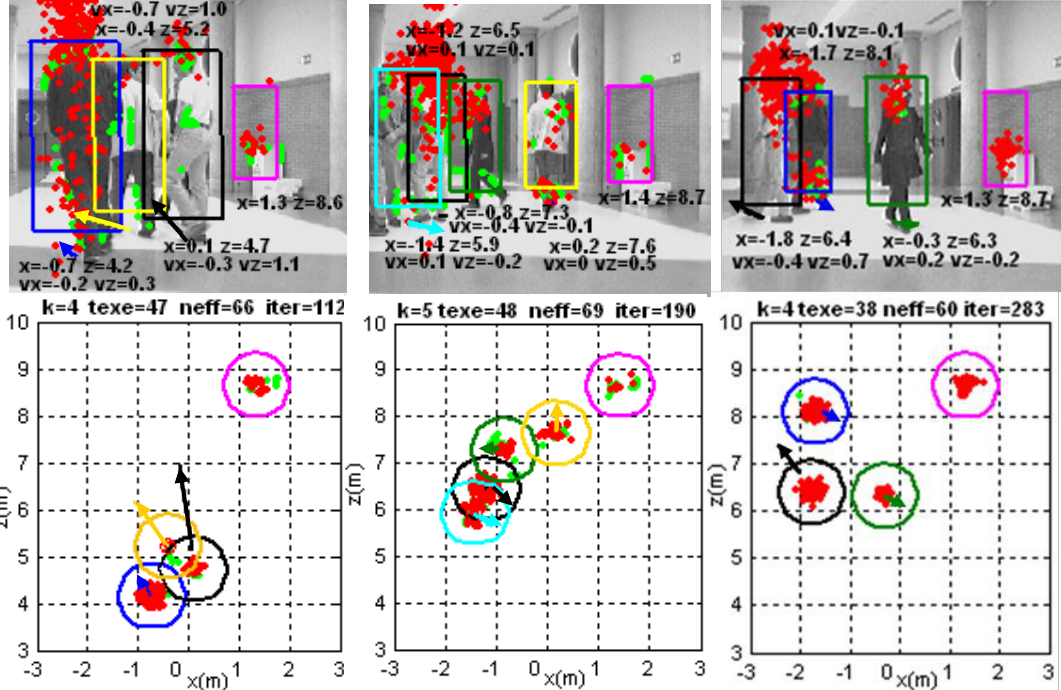
Figure 9. Results of the multi-tracking process in a real experiment. They are organized in columns, where the upper image shows the tracking results generated by the XPFCP for each object, projected in the image plane, and the lower one shows the same results projected into the XZ